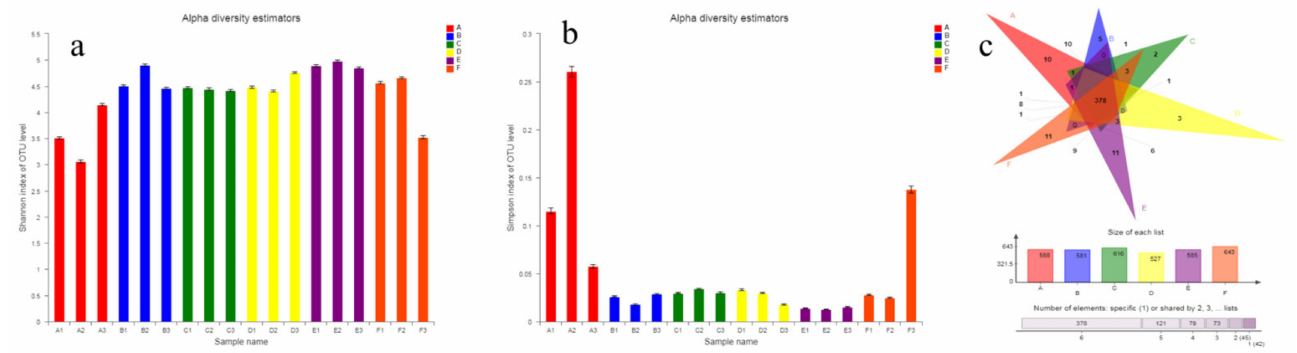
Figure 8. Alpha diversity ( a , b ) and Venn diagram ( c ) analysis (A, MG group; B, PG group; C, NG group; D, LDG group; E, MDG group; F, HDG